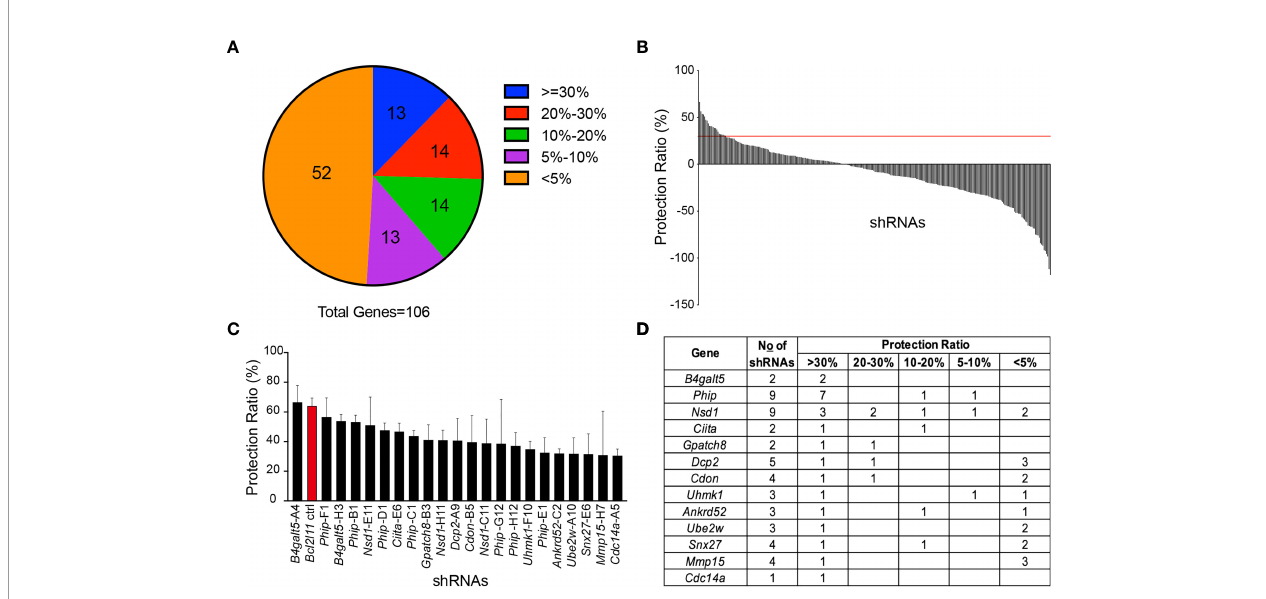
FIGURE 2 | Functional screen of the TransOMIC shRNA library. (A) Pie chart summarizing the screen results. Numbers inside the chart indicate the number of genes with shRNAs protecting WEHI-231 cells from BCR engagement-induced apoptosis at various ratios. The protection ratio = 1 – (active caspase 3 + % of WEHI- shRNA)/(active caspase 3 + % of WEHI-EV) under stimulated conditions. (B) Bar graph showing protection ratios of individual shRNAs. The red line indicates the 30% protection threshold. (C) Bar graph detailing individual shRNAs with >30% protection ratios. (D) List of genes with shRNAs exhibiting >30% protection ratios. Data are representative of 2 independent experiments for B4galt5 -H3 and Phip -E1, 3 for B4galt5 -A4, Phip -F1, Phip -B1, Nsd1 -E11, Phip -D1, Ciita -E6, Phip -C1, Nsd1 - H11, Dcp2 -A9, Cdon -B5, Phip -G12 and Cdc14a -A5, 4 for Bcl2l11 , B Gpatch8 -B3, Nsd1 -C11, Phip -H12, Uhmk1 -F10, Ankrd52 -C2, Ube2w -A10 and Snx27 -E6, and 5 for Mmp15 -H7. Graph bars indicate mean +